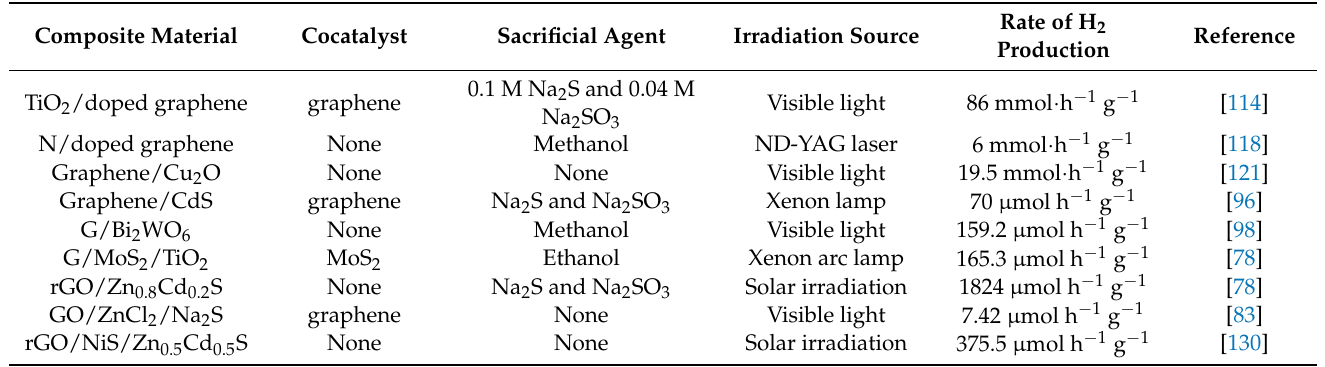
Table 3. Graphene-based composites and H 2 evaluation